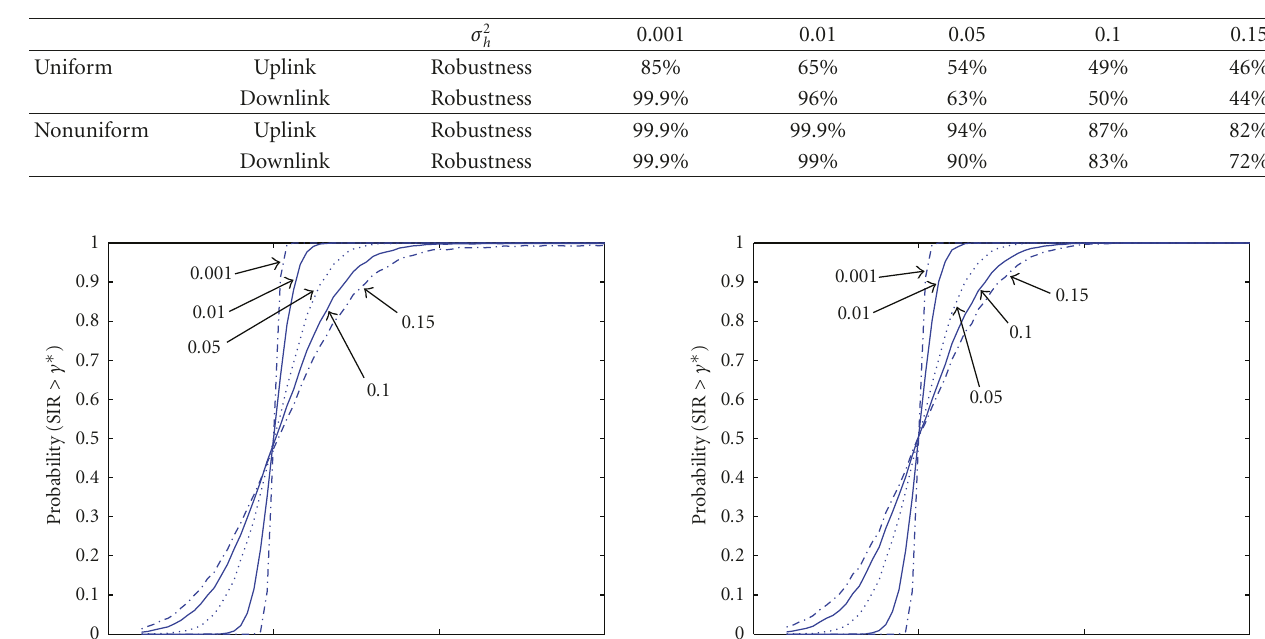
Table 9: Robustness of optimum sectorization against Gaussian estimation error.